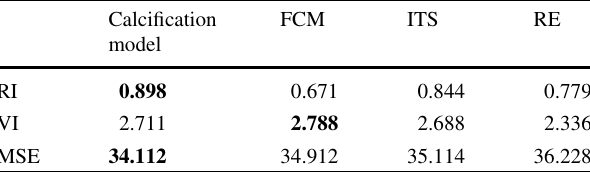
Table 5 Calcification model evaluation procedure of the third clinical expert Calcification model